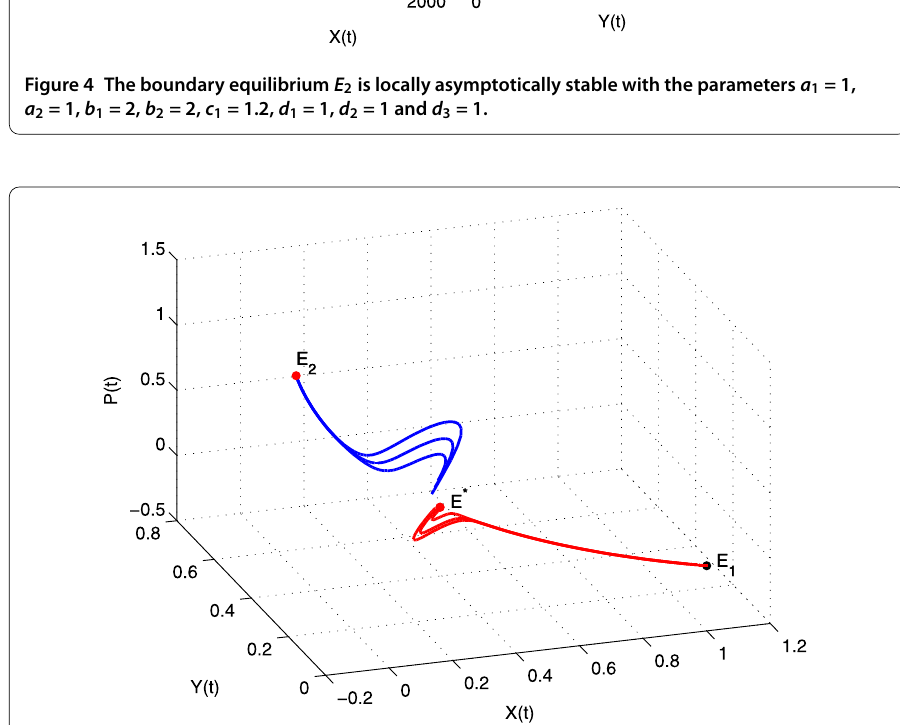
Figure 5 The positive equilibrium E ∗ is unstable, and both the boundary equilibrium E 1 and the boundary equilibrium E 2 are locally asymptotically stable with the parameters a 1 = 1, a 2 = 1, b 1 = 2, b 2 = 1, c 1 = 1.5, d 1 = 1, d 2 = 1 and d 3 =